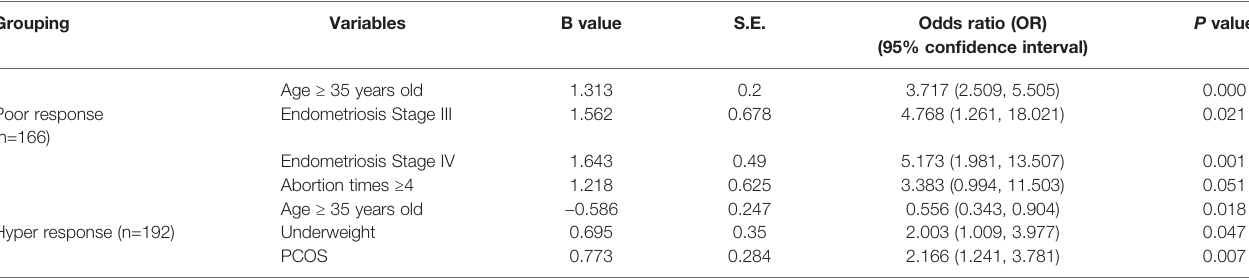
TABLE 1 | Logistic regression analysis results of statistically signi fi cant variables.